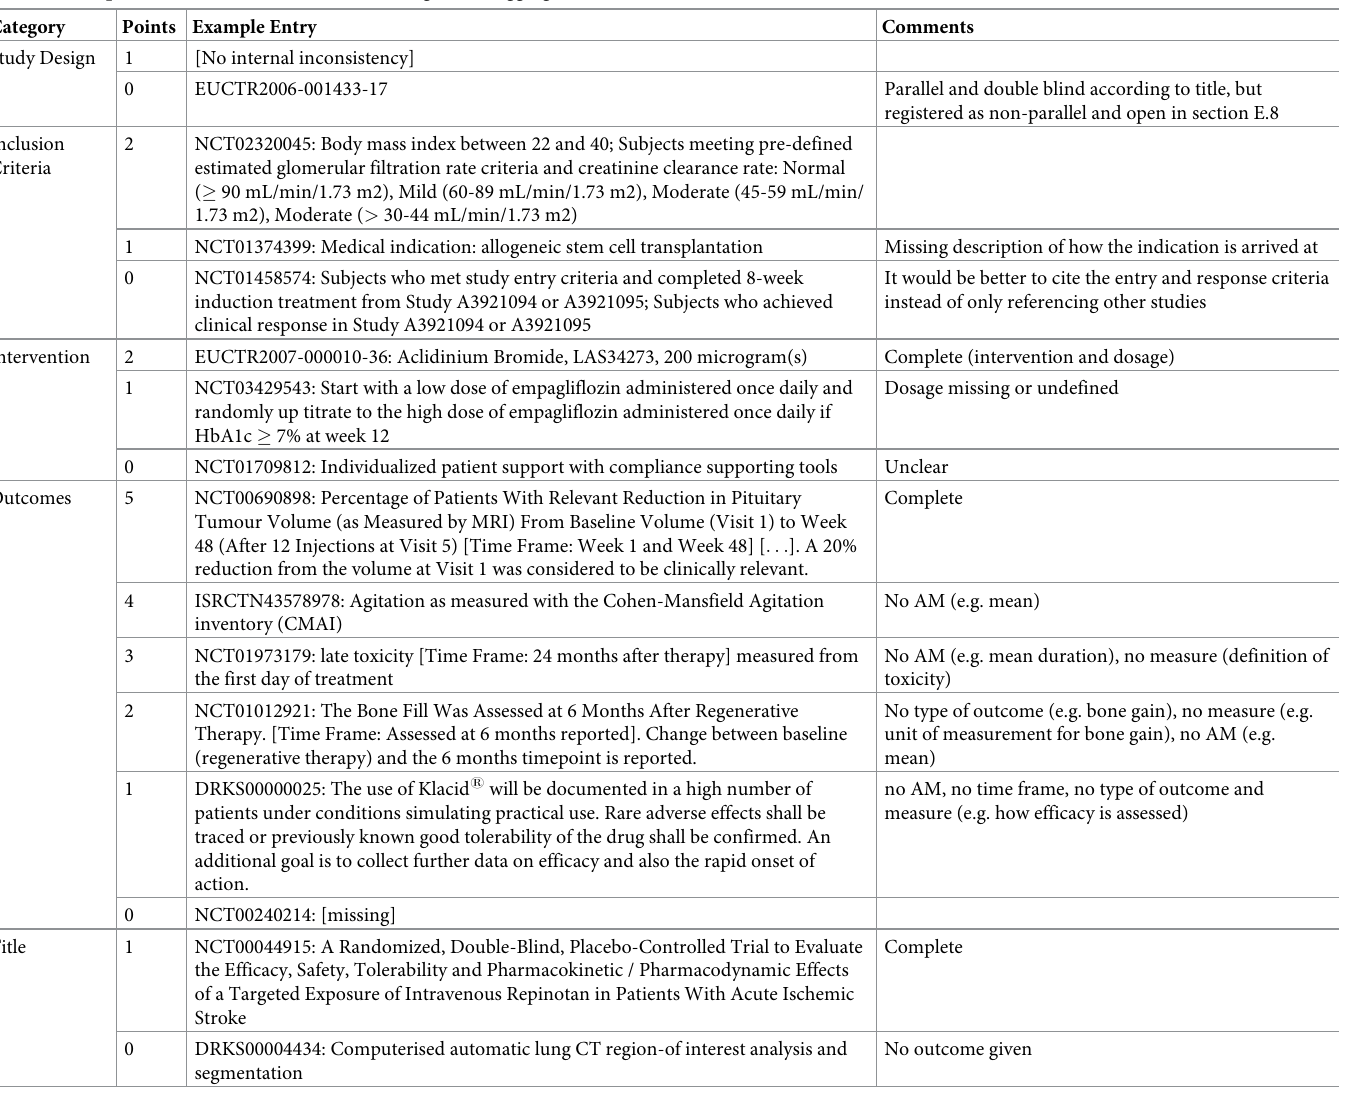
Table 1. Examples of database entries and their ratings (AM: Aggregation